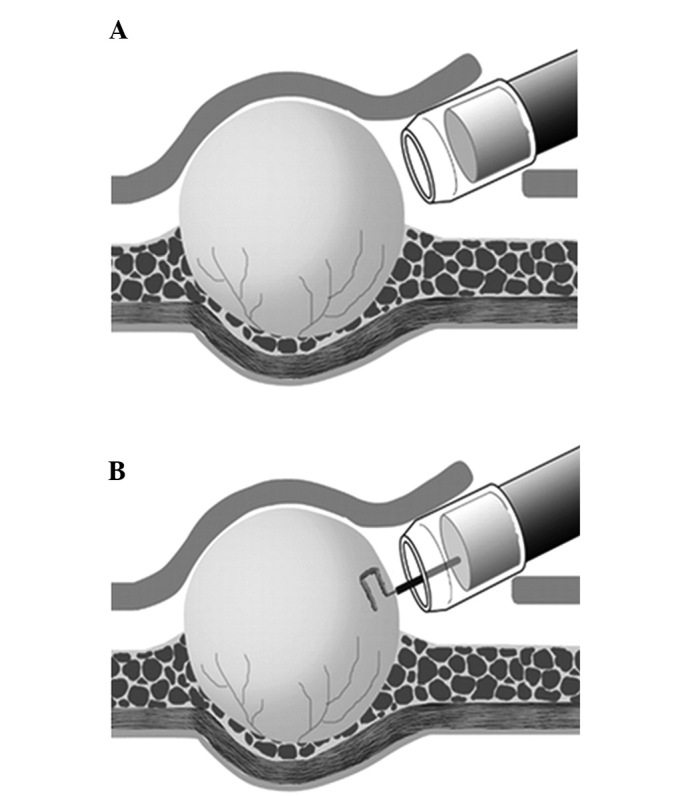
Bloc biopsy using the submucosal endoscopy mucosal flap (SEMF) method. (A) SEMF consisted of creating a short tunnel, via an additional submucosal dissection, to access the tumor. The characteristic endoscopically visualized feature findings of the submucosal tumors (SMTs) are shown in the submucosa from the dissected submucosal tunnel layer. (B) A bloc biopsy was performed to obtain a bloc specimen (size, 5×5×2 mm) using a needle-knife in the cutting mode of the electrosurgical unit. The hardness of the SMTs was assessed by applying pressure against the tumor using the needle-knife during the bloc biopsy.